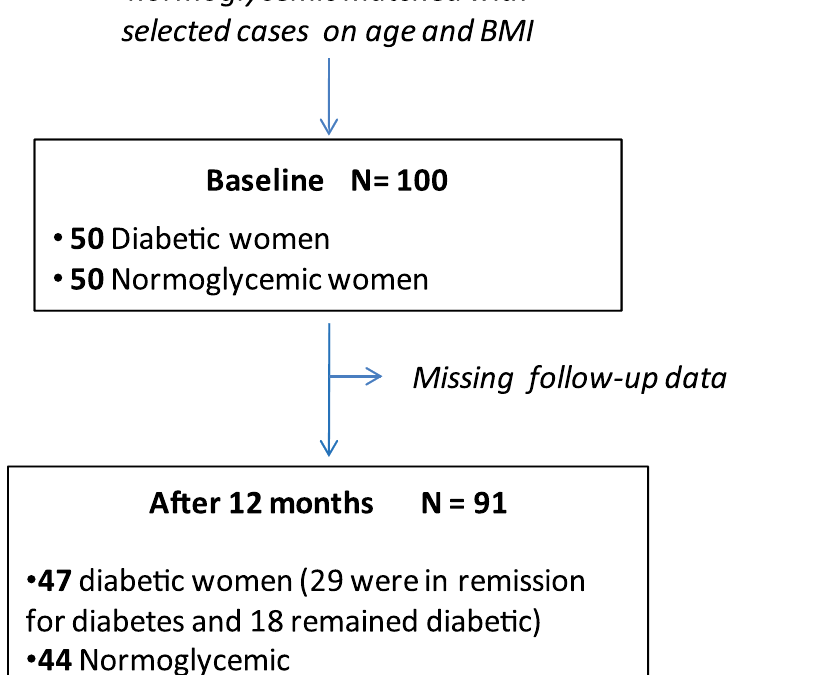
Fig 2. Flow chart of participants.